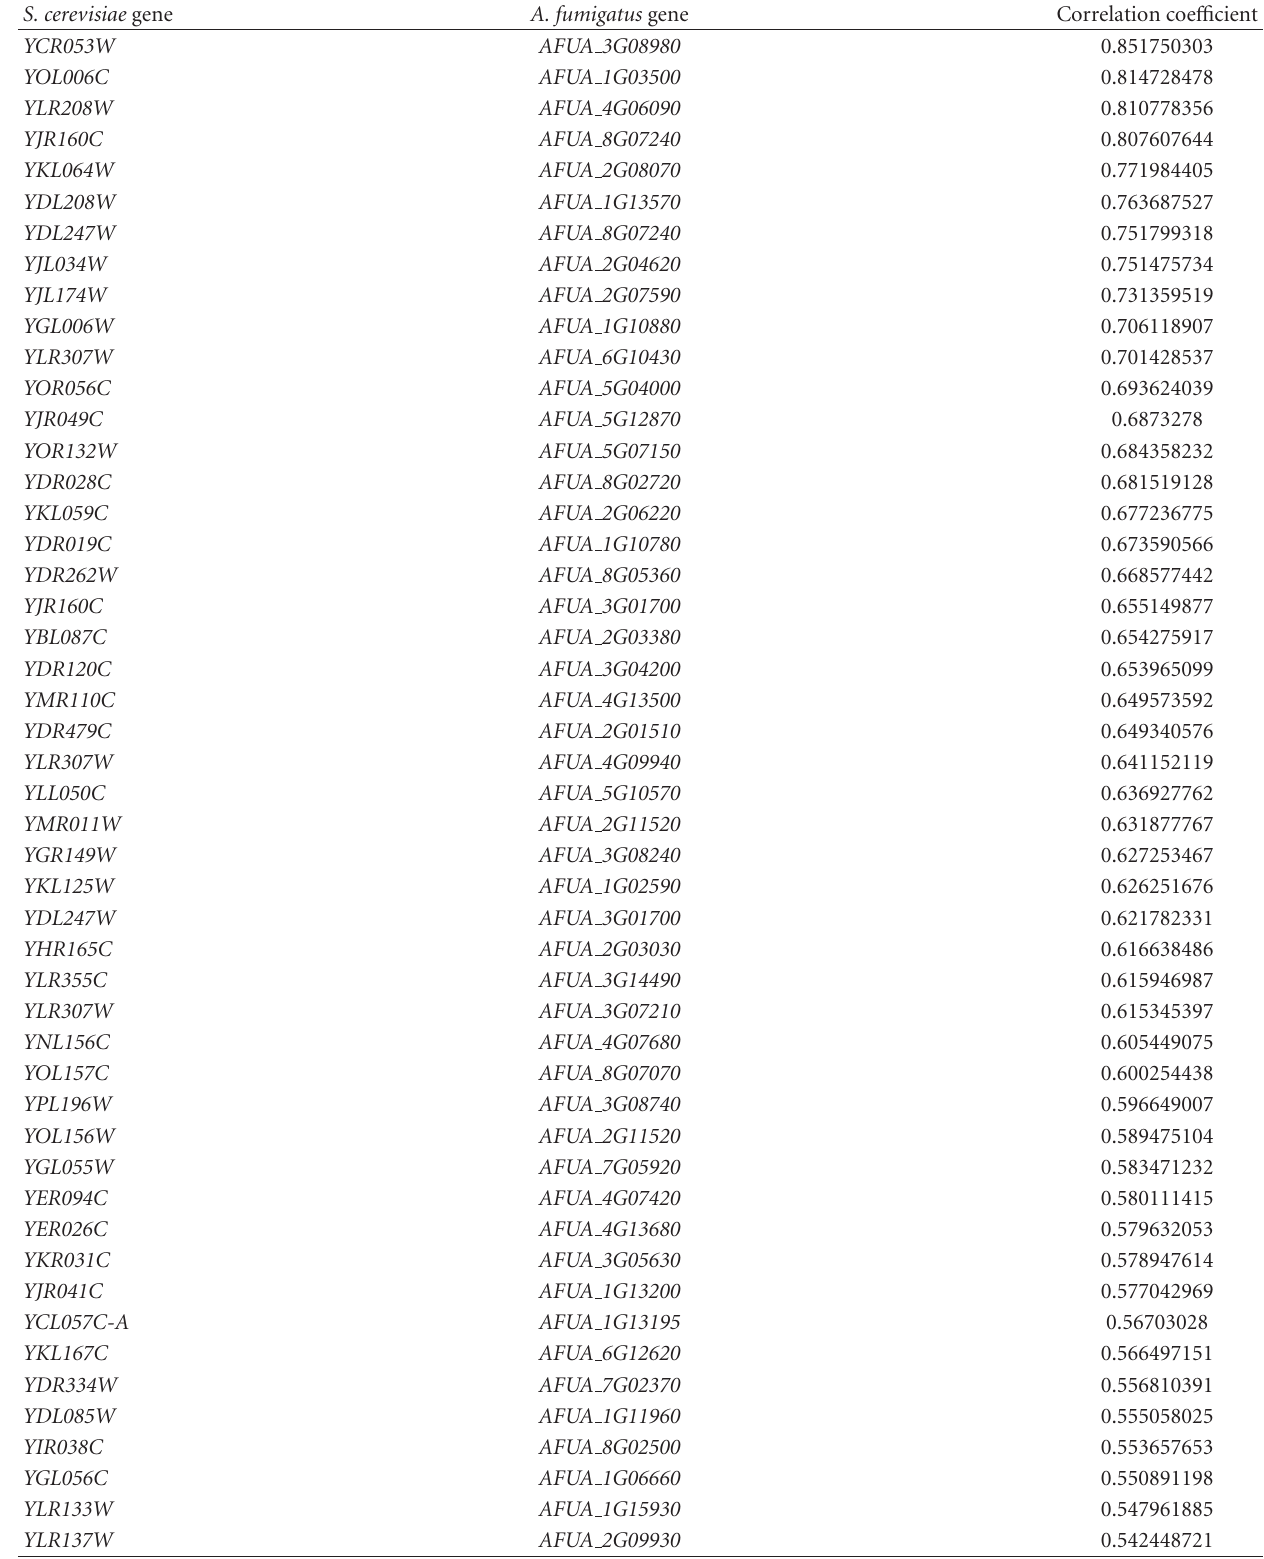
Table 4: Spearman’s rank correlation coe ffi cients between nucleosome position profiles in the promoters of 347 orthologous gene pairs between Aspergillus fumigatus and Saccharomyces cerevisiae